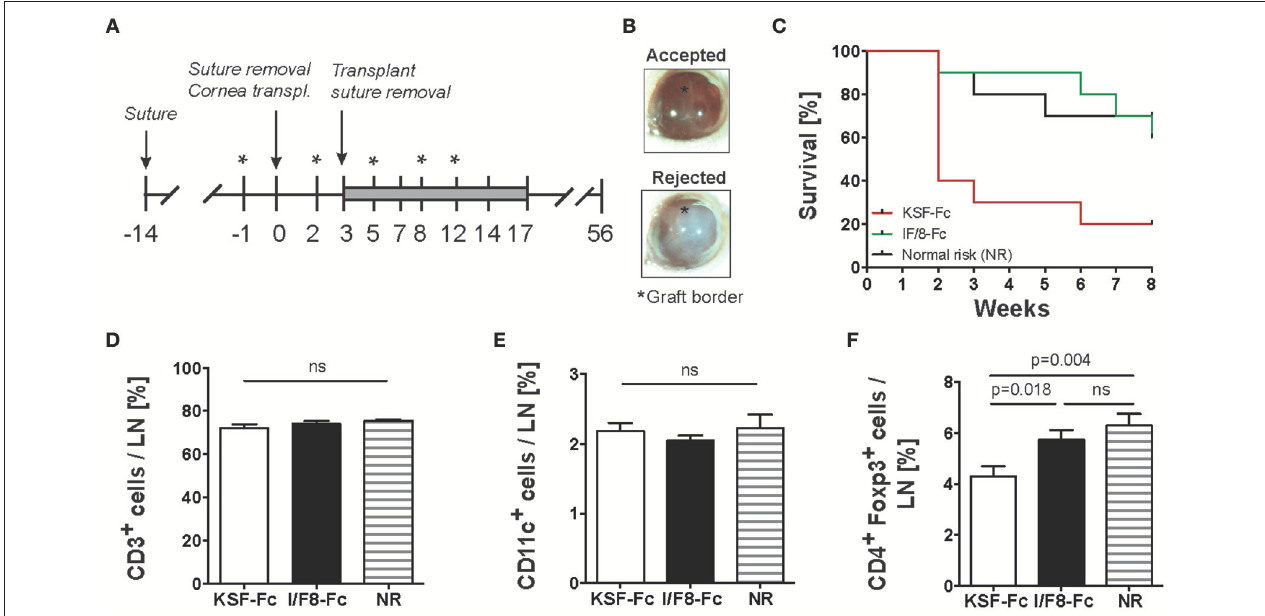
FIGURE 5 | ALCAM blockade reduces corneal allograft rejection. (A) Schematic description of the corneal allograft rejection model. On day − 14 three sutures were placed into the corneas of recipient BALB/c mice. On day 0, sutures were removed and the donor corneas from C57BL/6 mice were transplanted. Mice received I/F8-Fc or KSF-Fc control antibody i.p. (150 µ g) on day − 1, 2, 5, 8, and 12 (indicated by an asterisk). Additionally, mice were treated by topical application of antibody (3 µ g) twice a day for 14 days (day 3–14; gray bar). Transplant survival was monitored over 8 weeks (day 0–56). Transplants were considered rejected when the cornea lost its transparency. (B) Representative images of a surviving and a rejected cornea. The graft border is indicated by an asterisk. (C) Impact of antibody treatment on corneal allograft survival. NR group: normal risk group, consisting of mice that received a cornea transplant without the previous induction of suture-induced inflammation. Statistical analysis: I/F8-Fc vs. KSF-Fc: p = 0.024; I/F8-Fc vs. NR: p = 0.77; KSF-Fc vs. NR: p = 0.019. (D–F) FACS analysis was performed on eye-draining cervical LNs of all mice at the end of the study. Percentage of (D) CD45 + CD3 + T cells, (E) CD45 + CD11c + DCs (F) and CD45 + CD4 + Foxp3 + Tregs in cervical LNs. Pooled data from 2 experiments with a total of 10 mice /group are